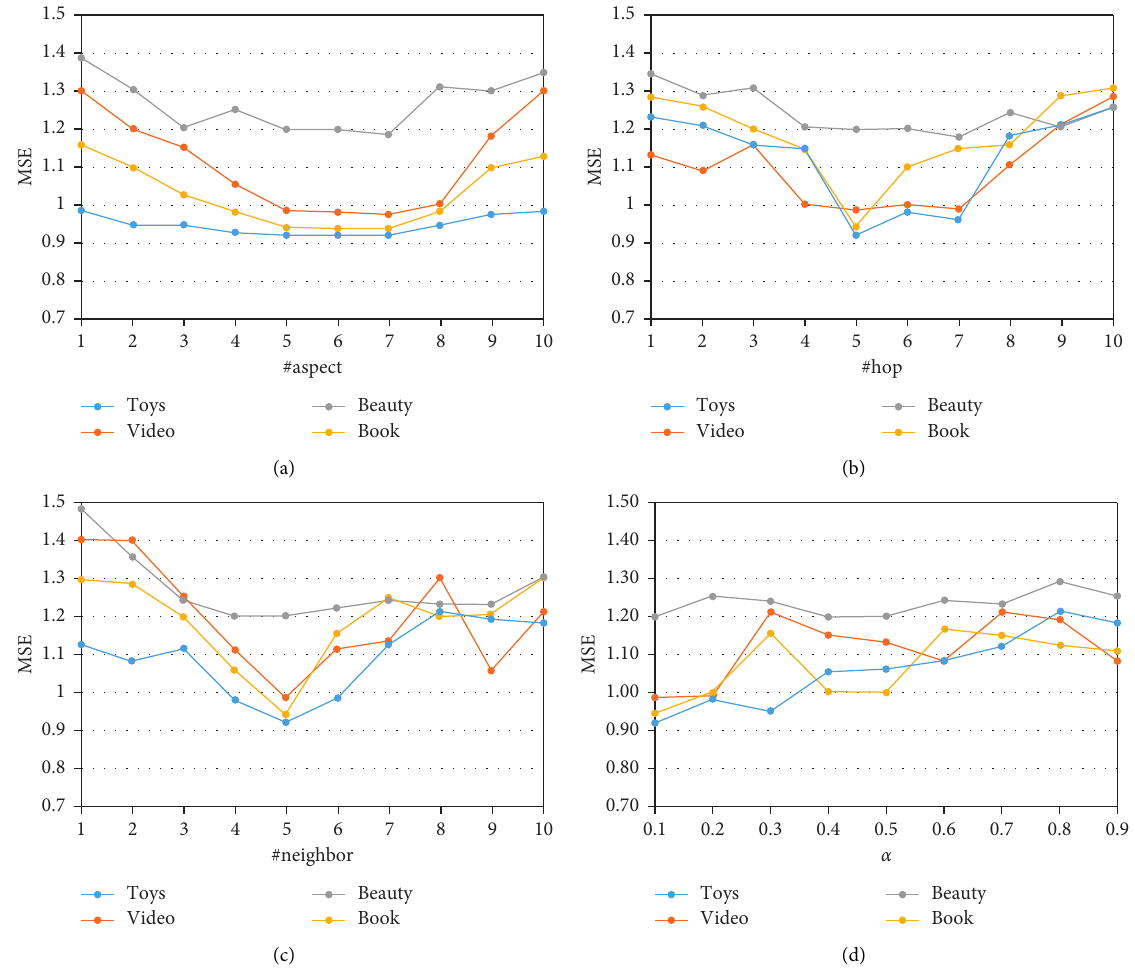
Figure 2: Parameter sensitivity of #aspect, #hop, #neighbor, and weighting parameter. (a) Effects of #aspect. (b) Effects of #hop. (c) Effects of #neighbor. (d) Effects of weighting parameter.